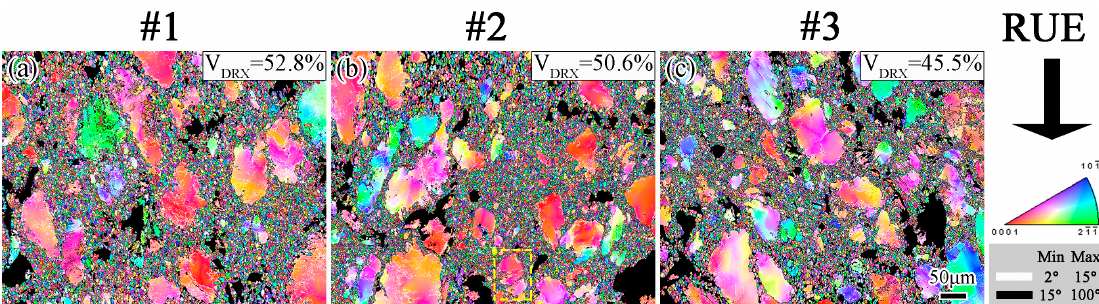
Figure 5. OIM maps of the edge of sample #1 ( a ), #2 ( b ) and #3 ( c ). The color-code of the stereographic triangle shows the crystallographic orientation of hcp crystal. Black lines indicate HAGBs larger than 15° and white lines indicate low-angle grain boundaries (LAGBs) between 2° and 15°.